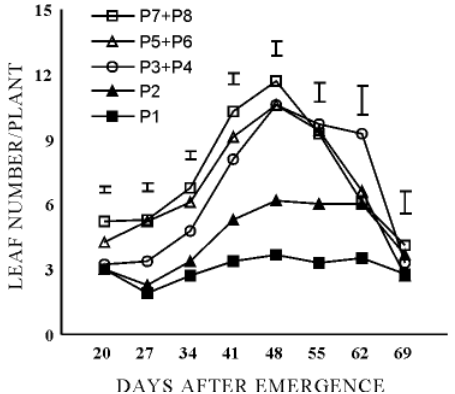
Figure 2. Mass and P accumulated in senesced leaves at each week of growth, of common bean plants grown at eight P levels applied to the soil (in mg kg -1 P): P1 5, P2 10, P3 20, P4 40, P5 80, P6 160, P7 320 P8 640; some P levels were grouped. Vertical bars represent the least significant difference (Tukey test at 0.05), and compare P levels within each